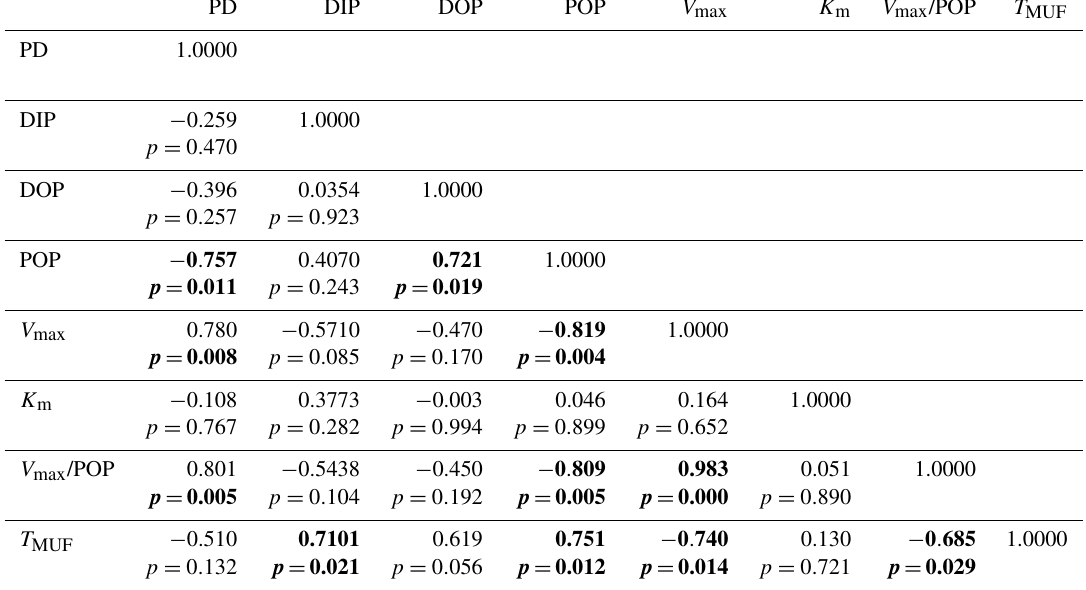
Table 4. Pearson correlation coefficients among biogeochemical variables related to the phosphorus pool inside the phosphate-depleted layer ( n = 10). PD: phosphacline depth. DIP: dissolved inorganic phosphate concentration. DOP: dissolved organic phosphorus. POP: particulate organic phosphorus. V max : AP maximum hydrolysis velocity. K m : AP Michaelis–Menten half-saturation constant. V max /POP: AP maximum hydrolysis velocity normalized to POP. T MUF : turnover time of the spiked DOP substrate, MUF-P. Significant correlations at p < 0 . 05 are highlighted in